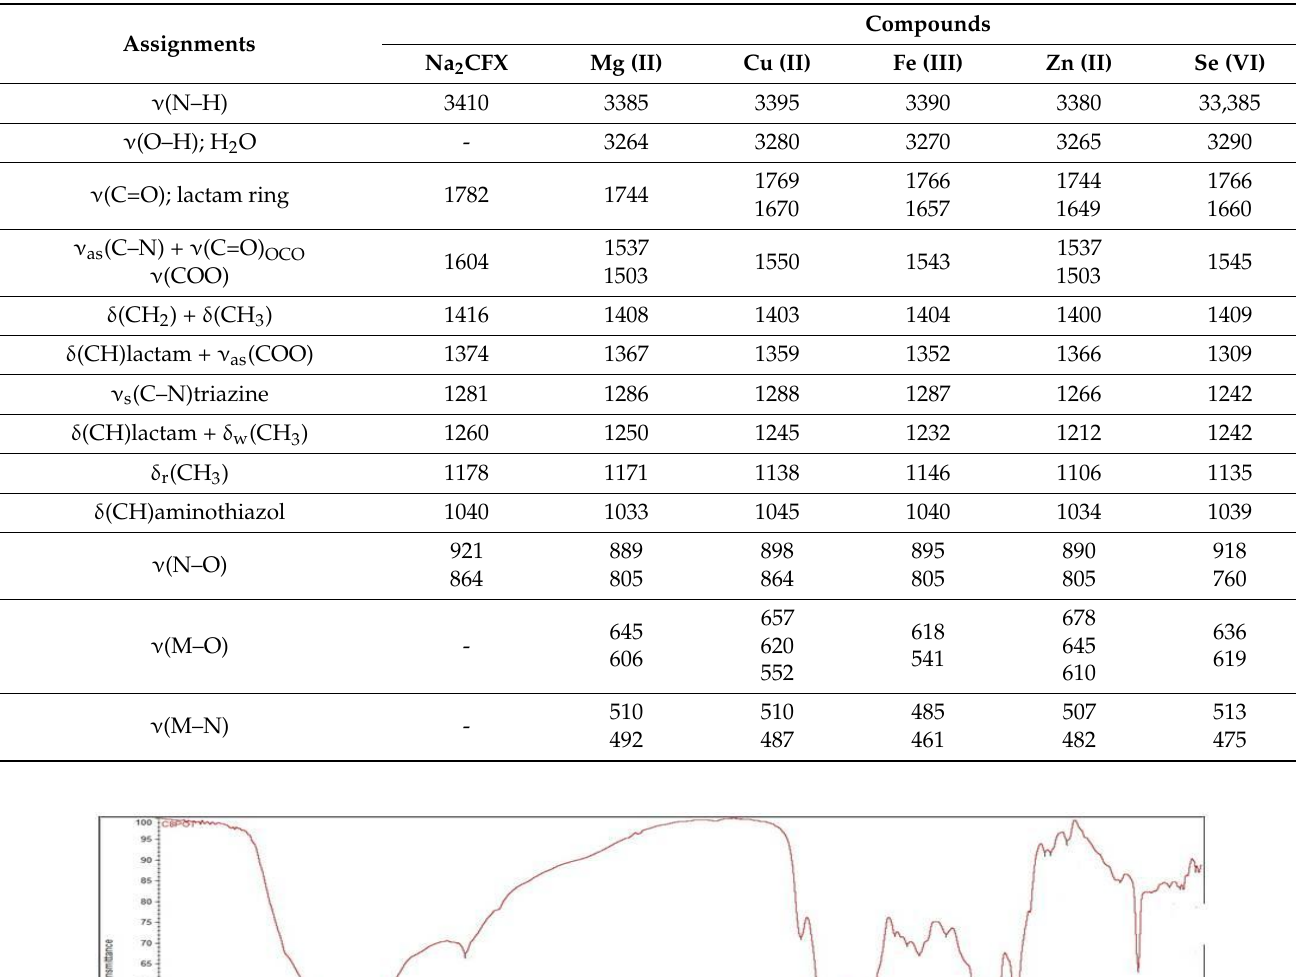
Table 3. Infrared frequencies (cm –1 ) for ceftriaxone and its complexes.